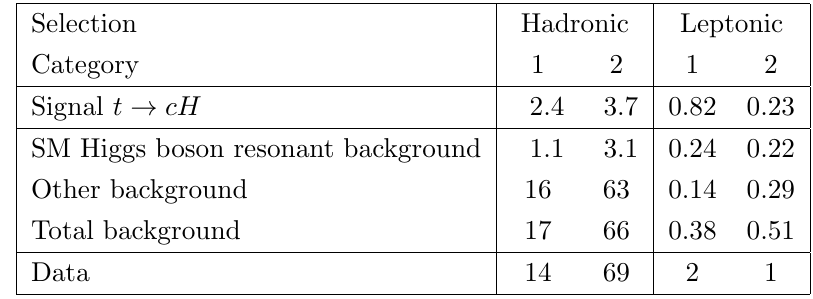
Table 3. Numbers of FCNC signal events in the SR ( m (cid:13)(cid:13) 2 [122 ; 129] GeV) for the (cid:12)tted t ! cH branching ratio B = 6 : 9 (cid:2) 10 (cid:0) 4 . The numbers of events for the SM Higgs boson production and the (cid:12)tted non-resonant background are also shown, together with the number of observed events in data, in the four